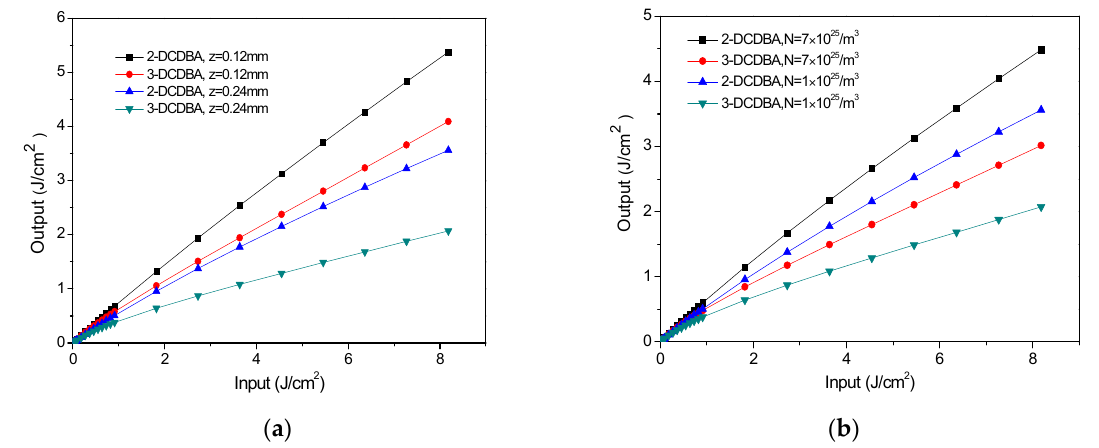
Figure 5. Optical limiting behaviors of 2-DCDBA and 3-DCDBA at ( a ) different propagation distances ( N = 1 × 10 25 /m 3 ) and ( b ) different particle number densities ( z = 0.24 mm). Table 2. The values of linear absorption coefficient α (10 3 m/W), the TPA coefficient β (nm/W), dynamical TPA cross section σ tp (10 5 GM), and the static TPA cross section (GM) of 2-DCDBA and 3-DCDBA at different propagation distances.